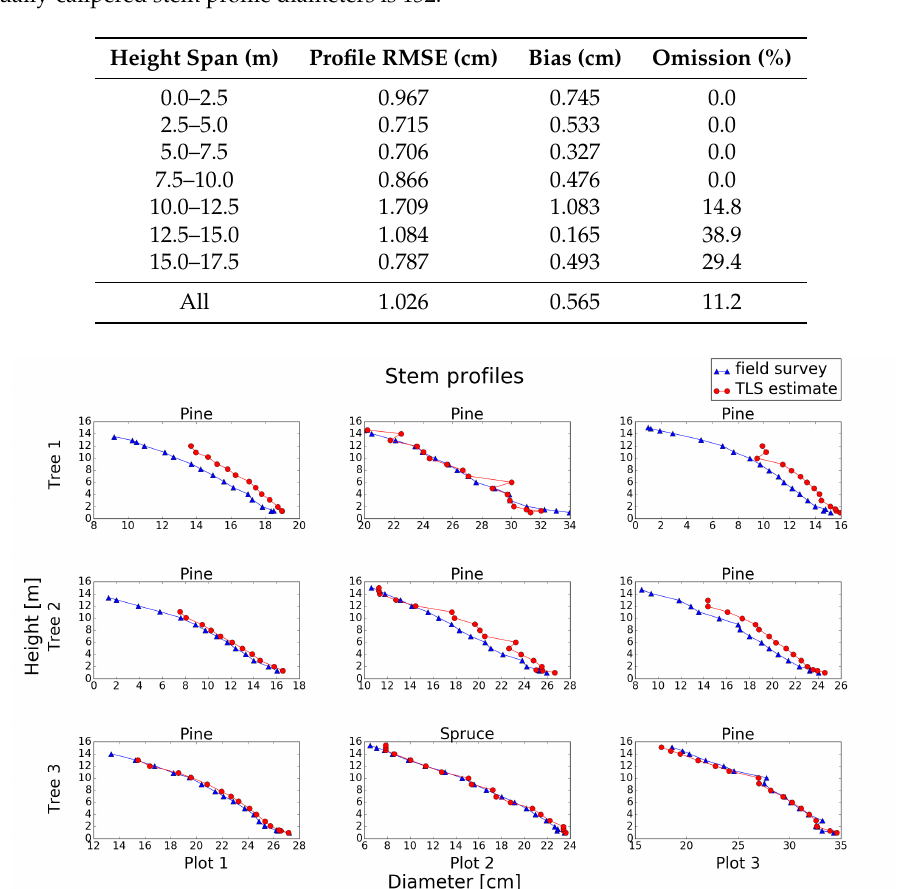
Table 9. Stem profile diameter RMSE and omission errors for different height spans of the spruce trees at the Svartberget test site. The parameter settings used in the stem profile detection method were: voxel size of 3 cm, curvature weight of 0.75 and cluster weight of 15. The total number of manually-calipered stem profile diameters is 152.